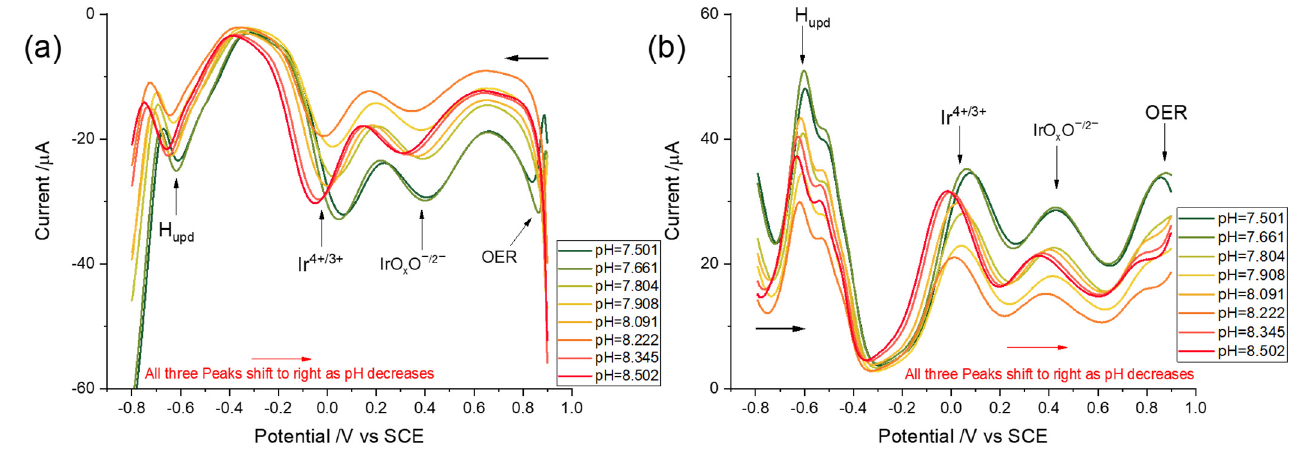
Figure 6. Square wave voltammograms (frequency 90 Hz, step potential 1 mV, and amplitude 60 mV) response using an activated iridium wire electrode in synthetic seawater with varying pHs ranging from 7.50 to 8.50 ( a ) reduction and ( b ) oxidation. Figure 7a and IrO x O I − /IrO x O II − H (Figure 7b) being calculated. The pH